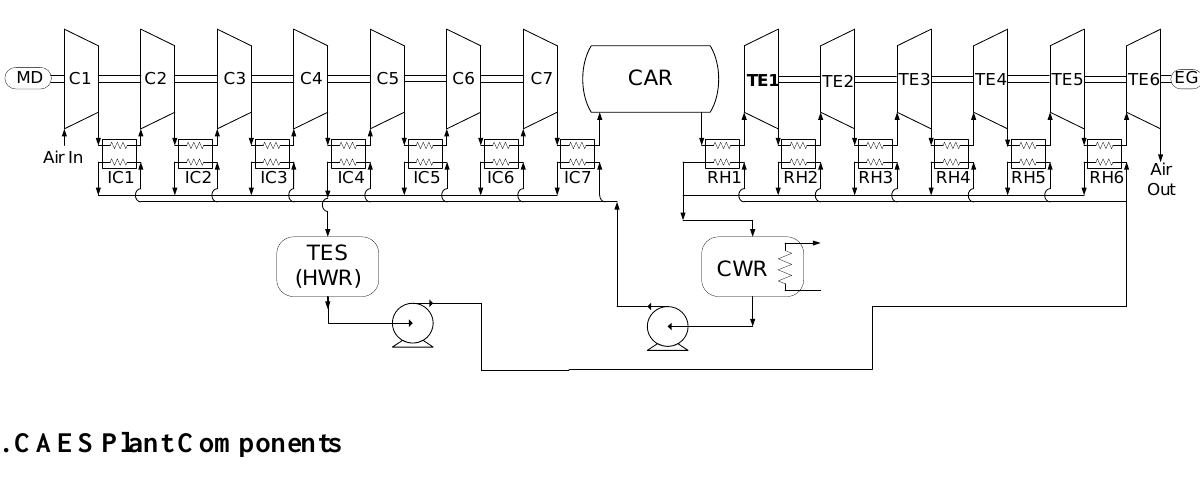
Figure 1. Schematic of the CAES